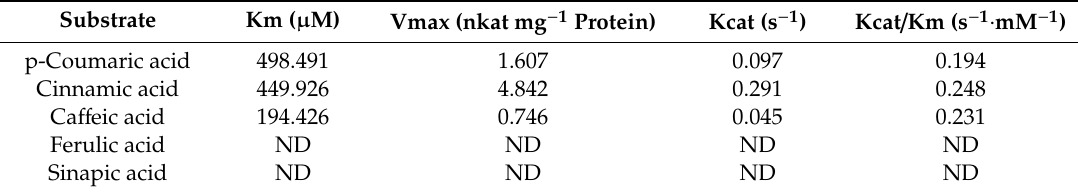
Table 5. Kinetic analysis of